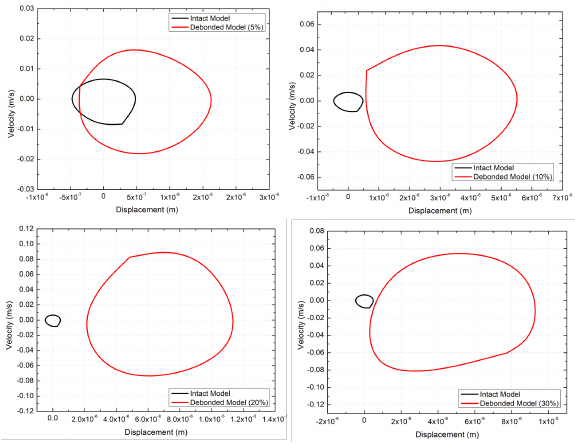
Figure 15: Comparison of phase portrait calculated at different measurement points at frequency ratio η